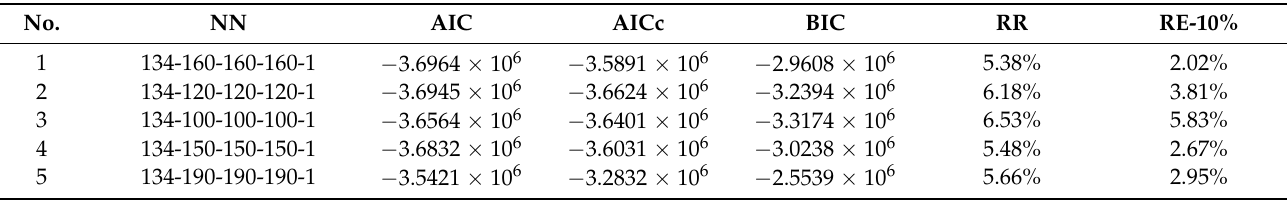
Table 2. Estimation results of different NN